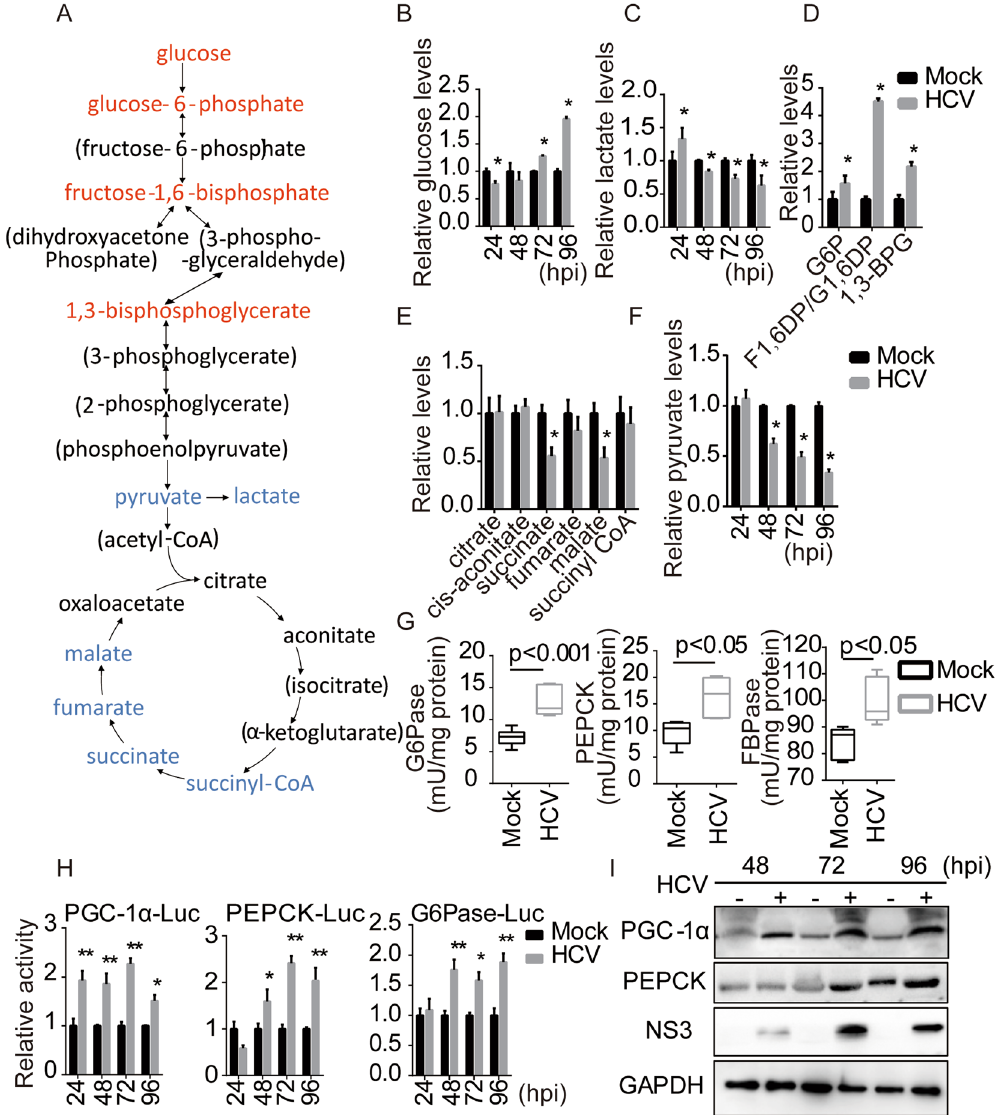
Figure 1. HCV infection redirects cellular metabolism towards gluconeogenesis. ( A ) Schematic illustrating the metabolites that are increased (red) or decreased (blue) in HCV-infected-HuH7 cells at 0.1 MOI and 96 hpi compared to mock-infected cells. Metabolites in parentheses were not measured. Levels of glucose ( B ), lactate ( C ), and pyruvate ( F ) at the indicated time points. Levels of glycolytic intermediates ( D ) and TCA cycle intermediates ( E ) at 96 hpi. Box plot diagram showing PEPCK, G6Pase and FBPase enzymatic activity ( G ) in mock- or HCV-infected-cells at 0.1 MOI and 96 hpi. The promoter activity of PGC-1 α , PEPCK, G6Pase ( H ), and related protein ( I ) levels in mock- or HCV(0.1 MOI)-infected-cells at the indicated time points. Data are represented as the mean ± SEM for triplicate